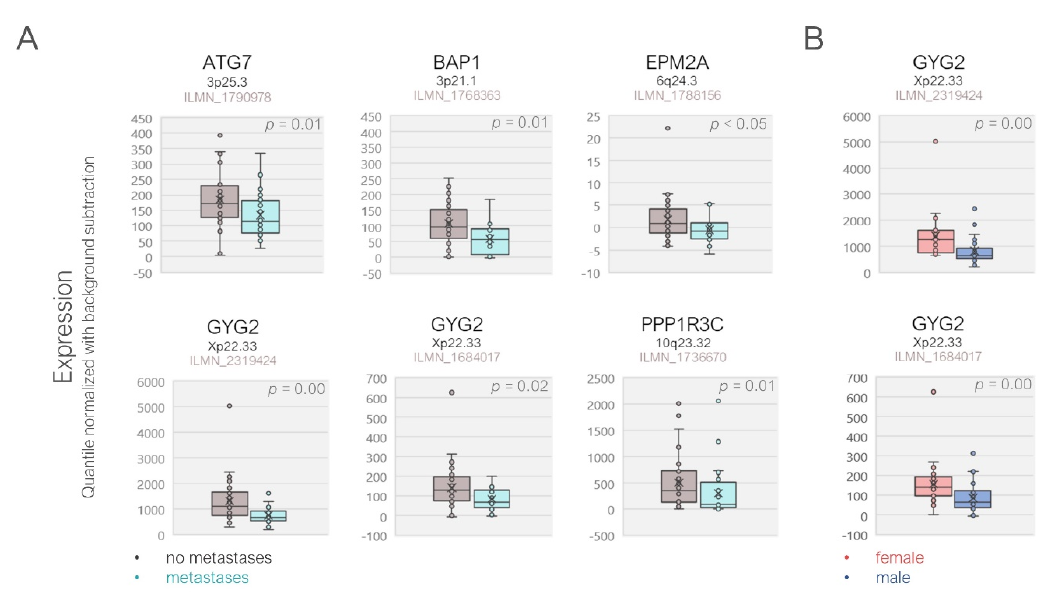
Figure 4. Differential gene expression in the validation cohort demonstrated by the scatter box plots. ( A ) The patients with metastases exhibited a significantly lower expression of the ATG7, BAP1, EPM2A, GYG2, and PPP1R3C genes. ( B ) GYG2 transcripts were also significantly lower in the tumors of the male versus female patients. p -Values were analyzed by the Mann–Whitney U test. The gene loci and the probe identifiers of the microarray are indicated underneath the gene symbols.